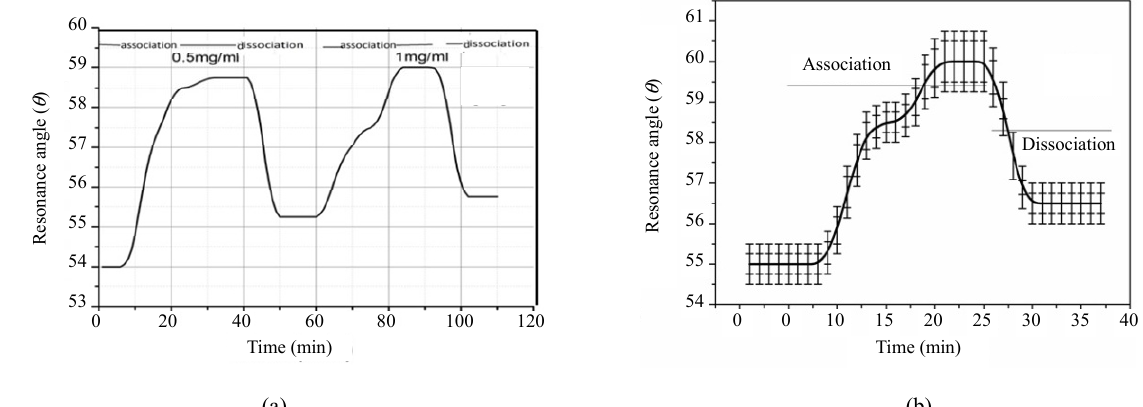
Fig. 8 SPR sensorgrams showing binding kinetic using venom proteins with different concentrations: (a) repeatability test and (b) under the same measurement condition using the analyte concentration of 1